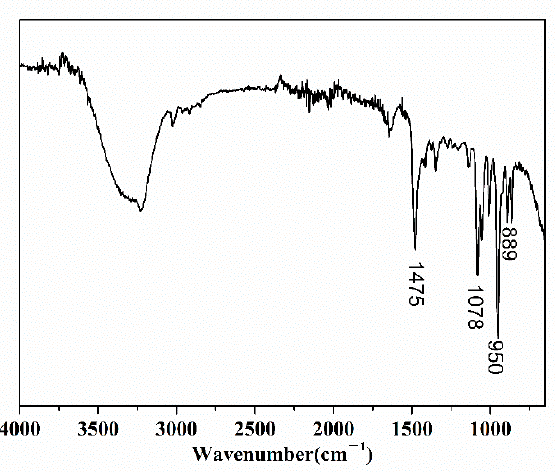
Figure 18. FTIR spectra of small molecules released by PDMC hydrolysis.